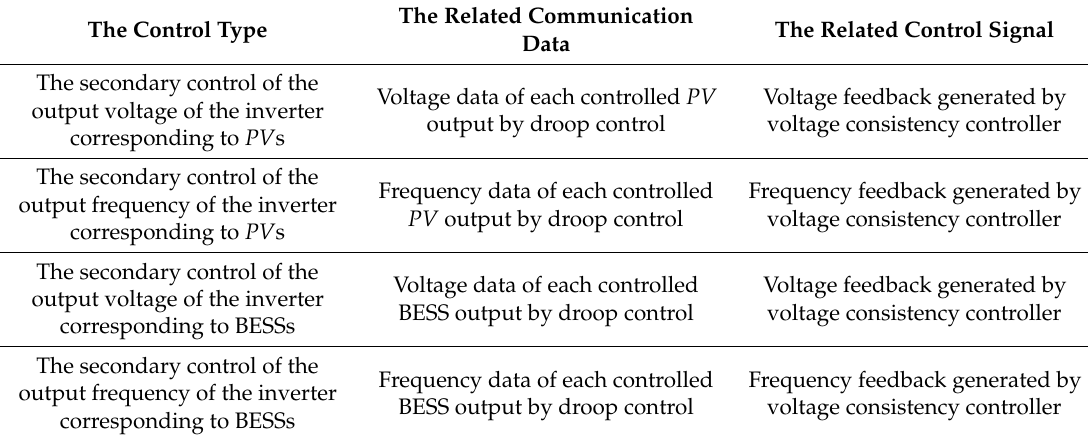
Table 2. The involved communication data and control signal in the secondary control